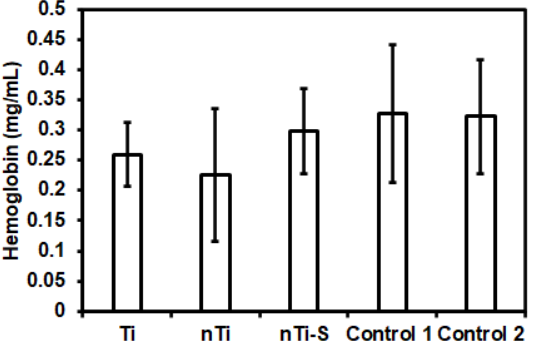
Figure 5. Hemoglobin release from erythrocytes solution incubated with different surfaces was measured using a microplate reader. (n min = 9.)